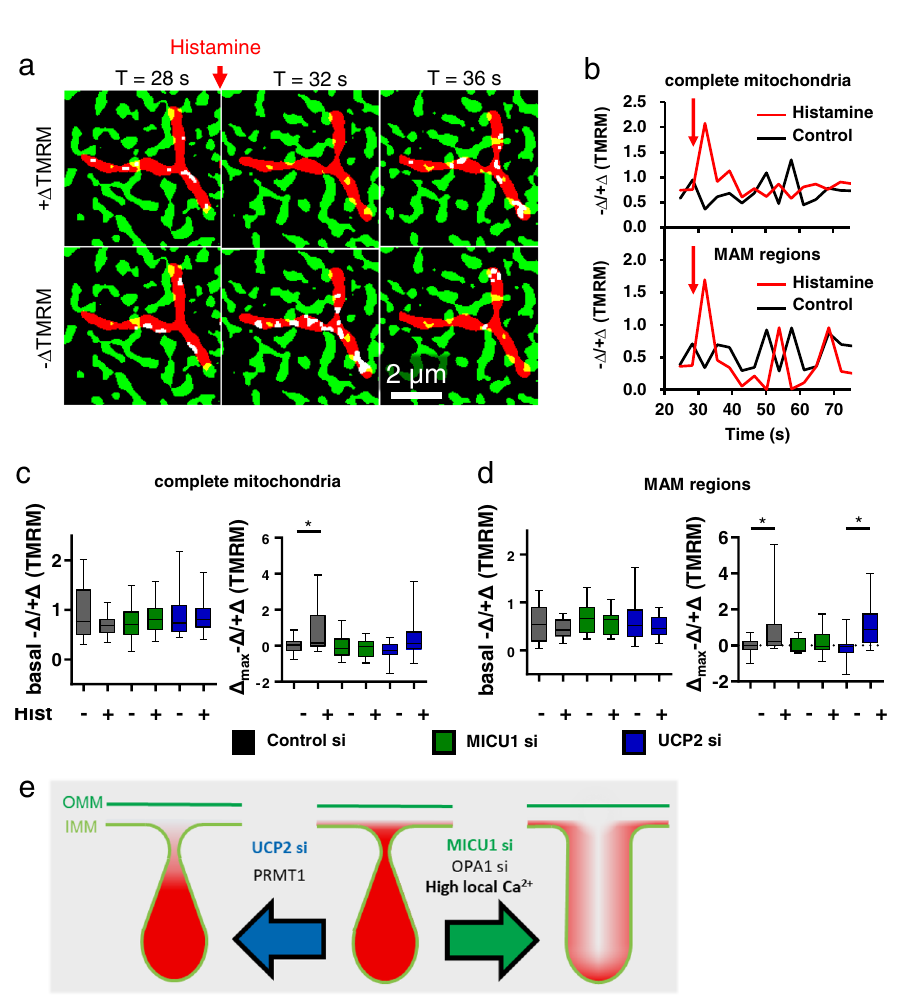
Fig. 4 Spatial loss of ΔΨ m after ER Ca 2 + release is modulated by MICU1 and UCP2. a Binarized labeling of HeLa cells at T = 28s, 32s, and 36s showing thresholded mitochondrial (TMRM; red), endoplasmic reticulum (ERAT 4.0 NA; green) and MAMs (yellow) structures as well as positive ( + Δ TMRM) or negative ( − Δ TMRM) local TMRM intensity changes (white). b Quanti fi cation of spatial restricted drops in membrane potential de fi ned as − Δ / + Δ TMRM over time in HeLa cells challenged with or without histamine in the complete mitochondria and (upper panel) in spatial proximity to MAMs (lower panel). The red arrows point to the addition of histamine. Statistical quanti fi cation in whole mitochondria in c and regions with close proximity to MAMs in d of basal (left panel) and maximum delta (right panel) − Δ / + Δ TMRM ratios in HeLa cell transfected with siRNA against control, MICU1, or UCP2. e Schematic depiction of CJ opening or closing and redistribution of local membrane potential upon knockdown of UCP2, MICU1, or OPA1 as well as the in fl uence of PRMT1 expression and high local Ca 2 + concentrations. Data information: data areshown as themean + / − SEM ( n Control si, control = 9/23, n Control si, hist = 10/29, n MICU1 si, control = 8/24, n MICU1 si, hist = 9/26, n = 8/20, n = 9/24,withdays/cells).* P <0.05vs.respectiveuntreated(CaB)controlconditionscarriedoutwithunpaireddouble-sided T UCP2si,control UCP2si,hist